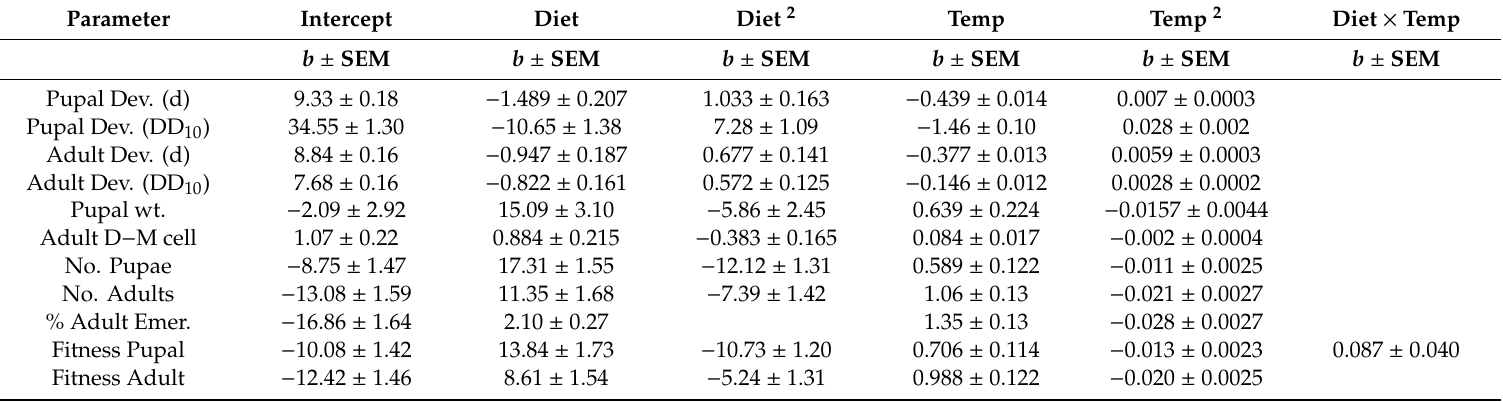
Table 3. Parameters for regression models describing stable fly developmental parameters relative to diet and